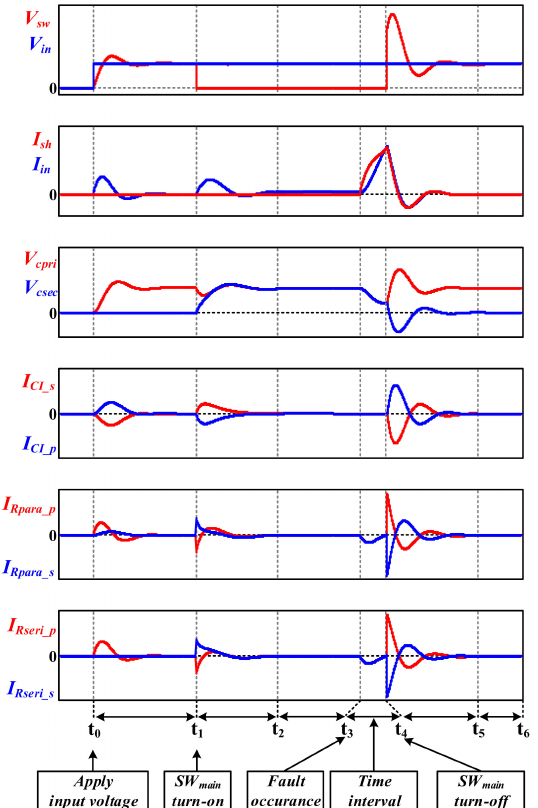
Figure 3. Key waveforms of the SSCB-CI under operation